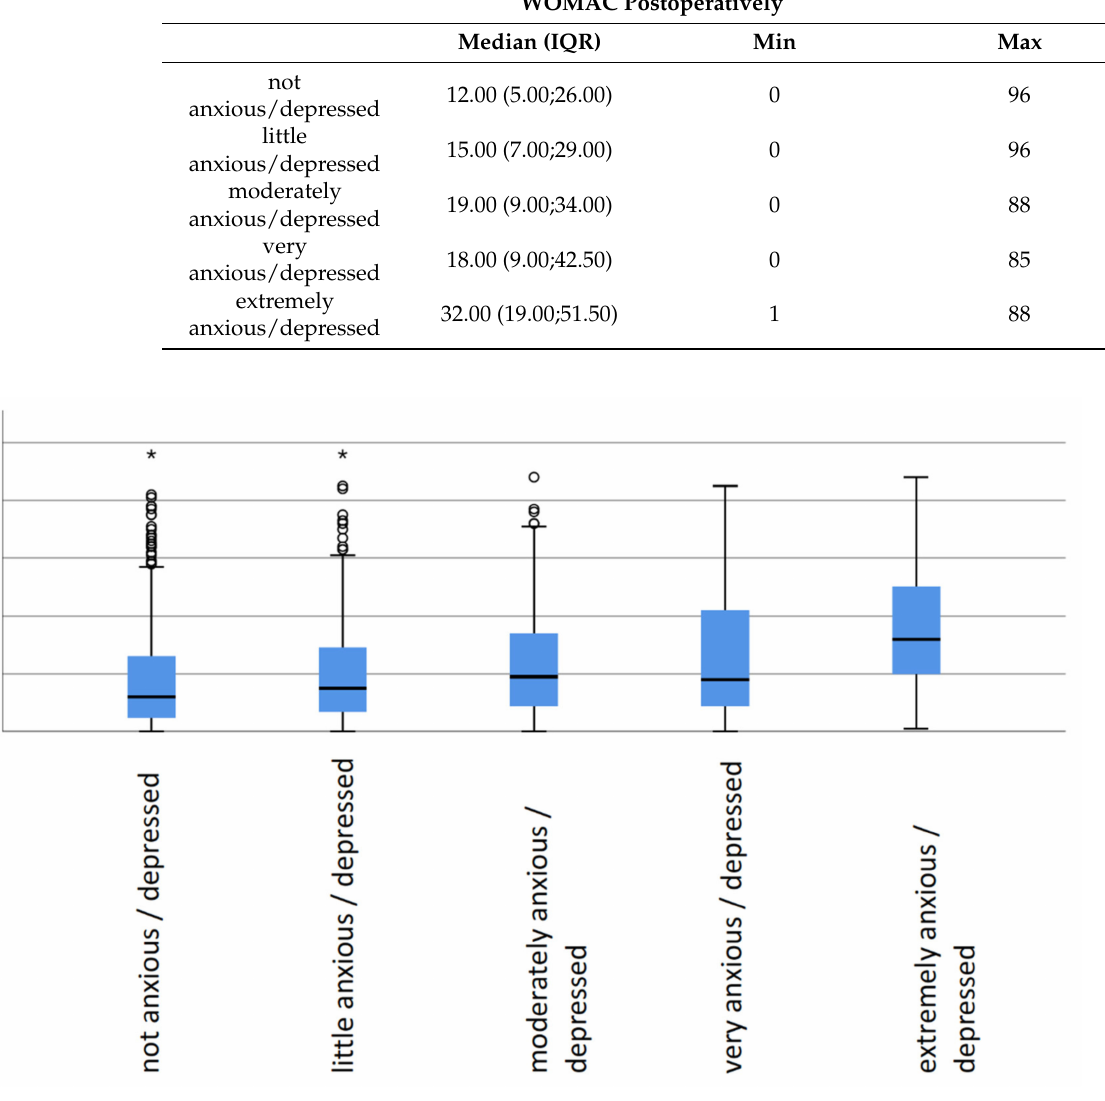
Figure 3. Boxplot: Western Ontario and McMaster Universities Osteoarthritis Index (WOMAC) postoperatively in depen- dence of preoperative anxiety/depression status. * are